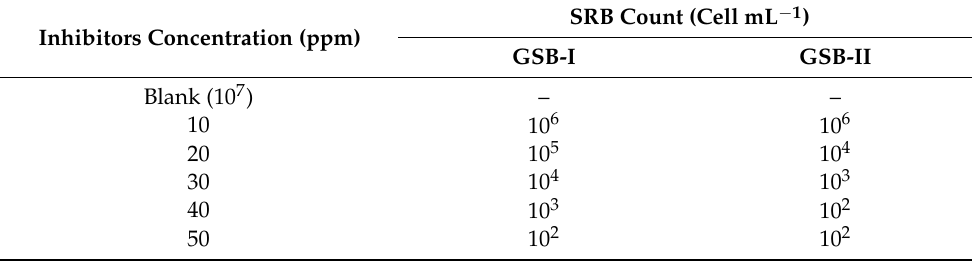
Table 4. Biocidal effect of the GSB inhibitors toward SRB. Inhibitors Concentration